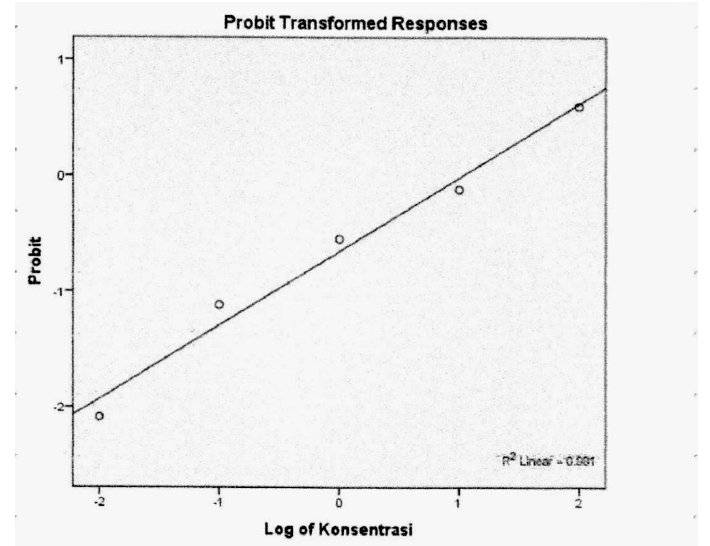
Fig. 2. Probit analysis of the inhibition of bacterial extract on the Plasmodium parasite.